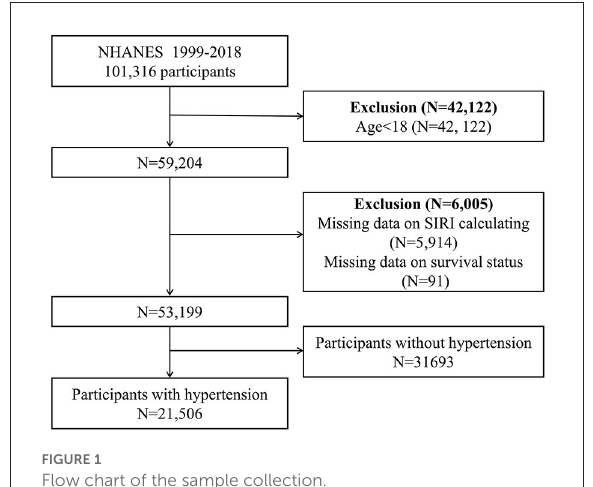
FIGURE1 Flow chart of the sample